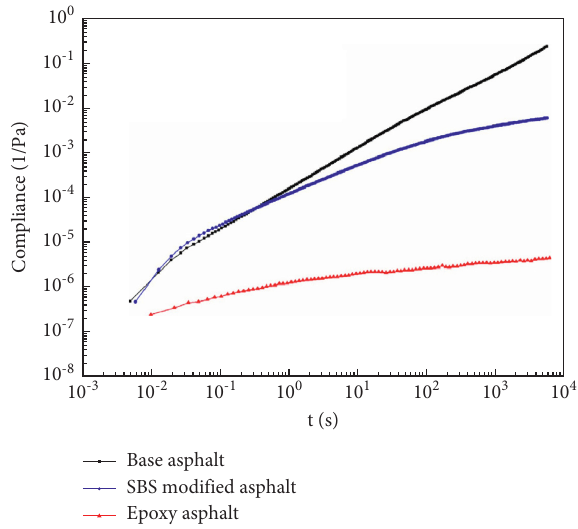
Figure 19: Creep behavior of binders at 40 ° C and 100Pa